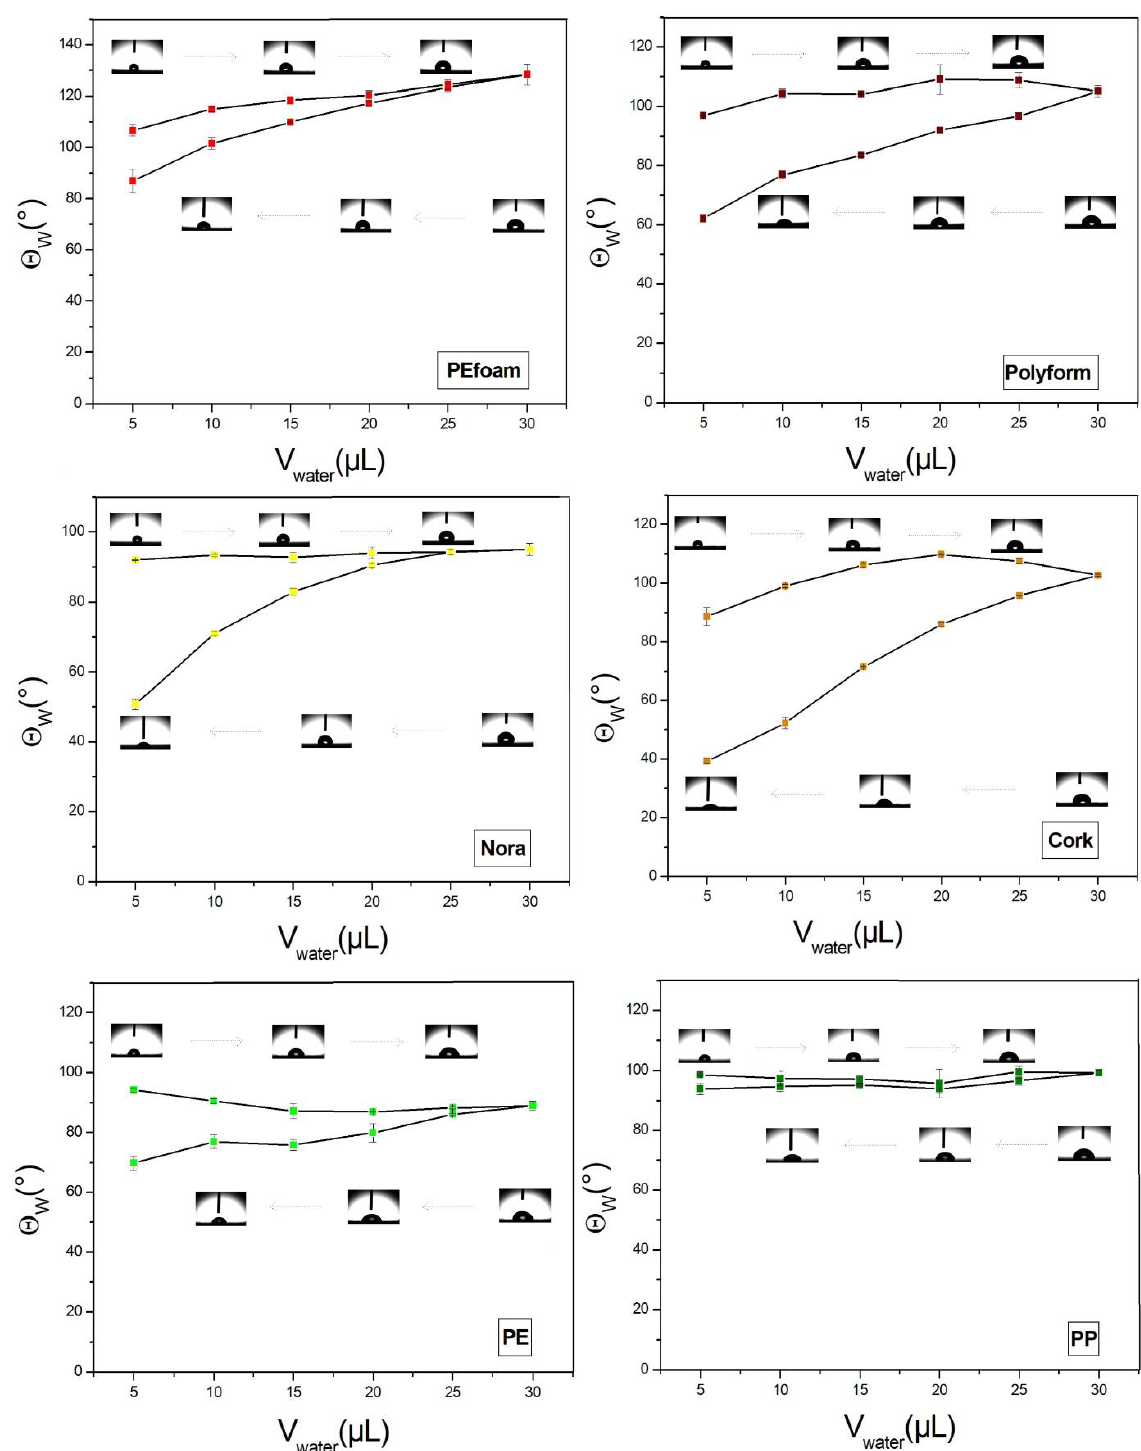
Figure 4. Contact angles of water droplet on six different materials: PEfoam, Polyform, Nora, cork, PE and PP. Advancing (upper curves) and receding (lower curves) contact angles are shown. Insets show liquid droplets on the material surfaces.